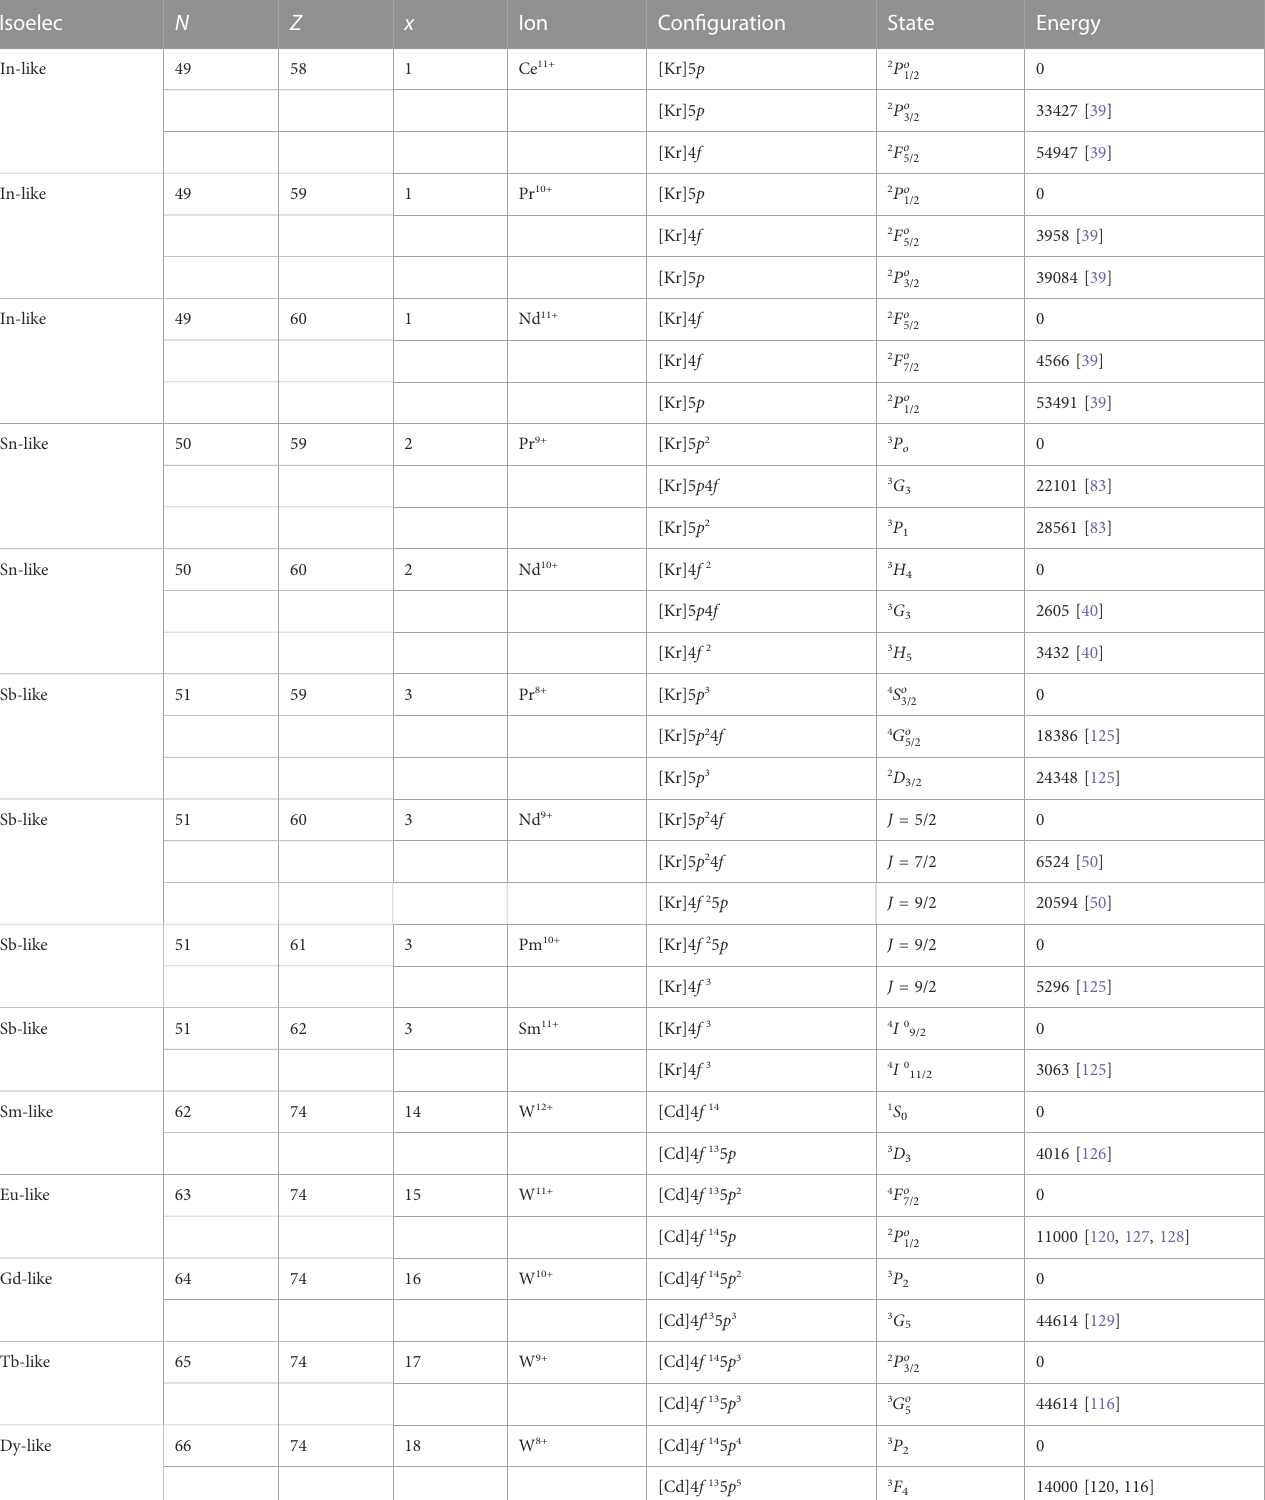
TABLE10 The energy level of HCIs in the isoelectronic sequences containing the different number of 5 p and 4 f valence electrons x , where N is the number of the electron, Z is the atomic number. [Kr] ” 1 s 2 2 s 2 2 p 6 3 s 2 3 p 6 3 d 10 4 s 2 4 p 6 and [Cd] ” 1 s 2 2 s 2 2 p 6 3 s 2 3 p 6 3 d 10 4 s 2 4 p 6 4 d 10 5 s 2 . Units of all values are in cm − 1 . Isoelec N Z x Ion Con fi guration State Energy